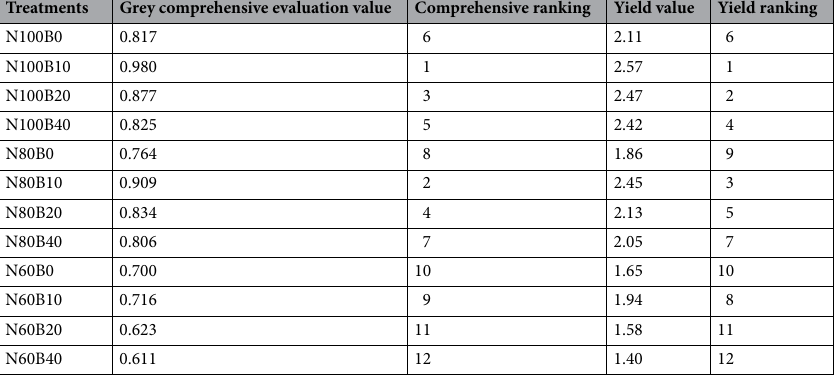
Table 4. Grey judgement analysis of soil fertilization in different treatments.